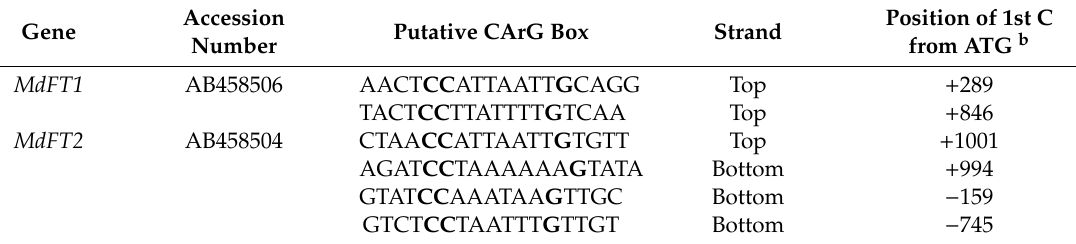
Table 1. Putative CArG boxes in MdFT a